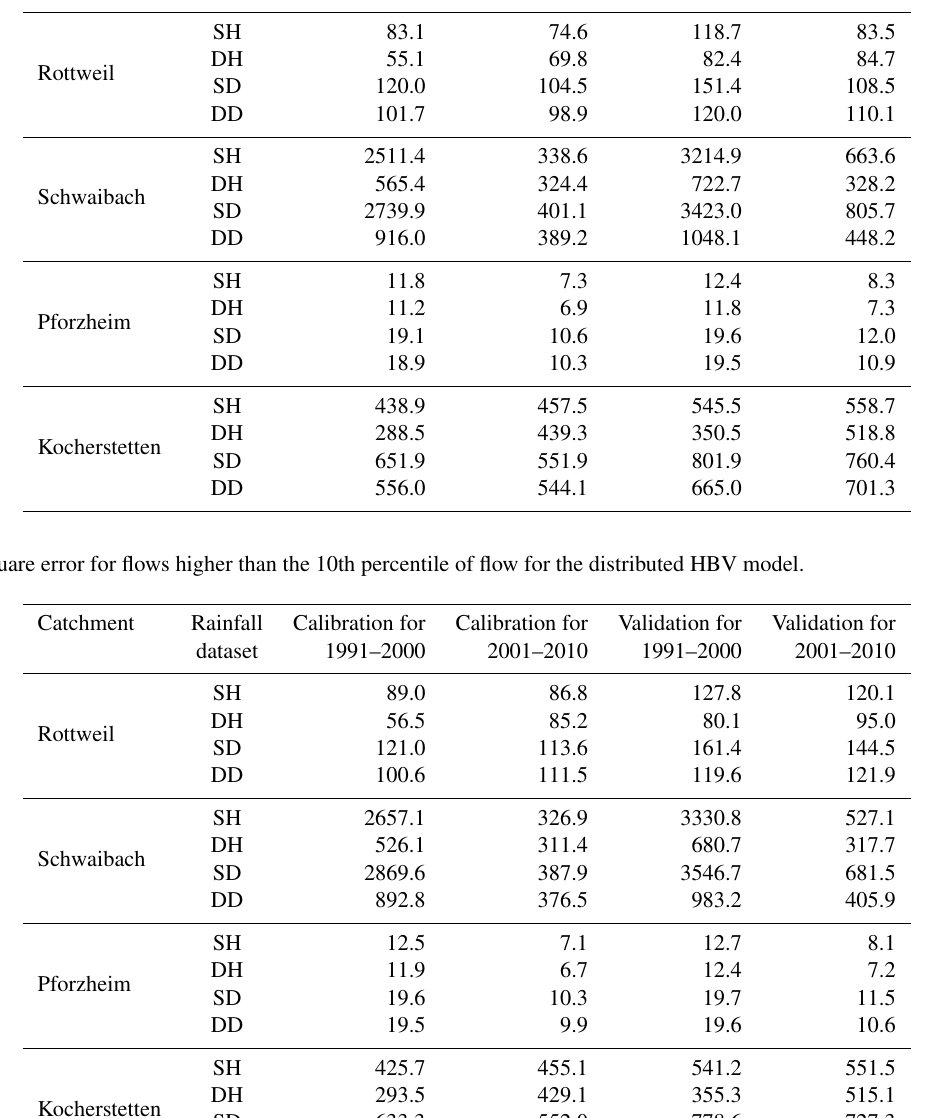
Table 5. Mean square error for flows higher than the 10th percentile of flow for the lumped HBV model. Catchment Rainfall Calibration for Calibration for Validation for Validation for dataset